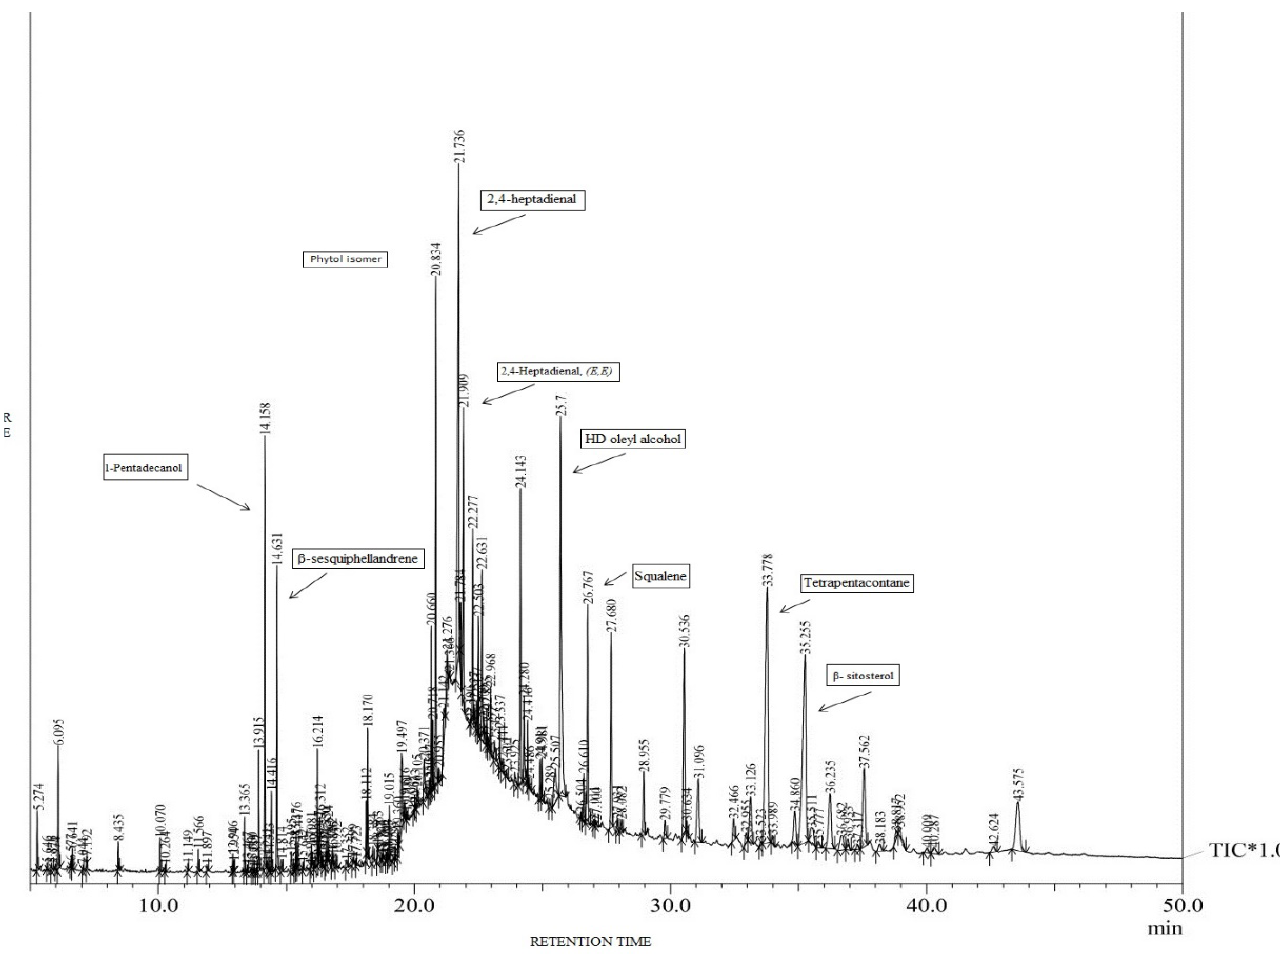
FIGURE 1 – Hexane extract